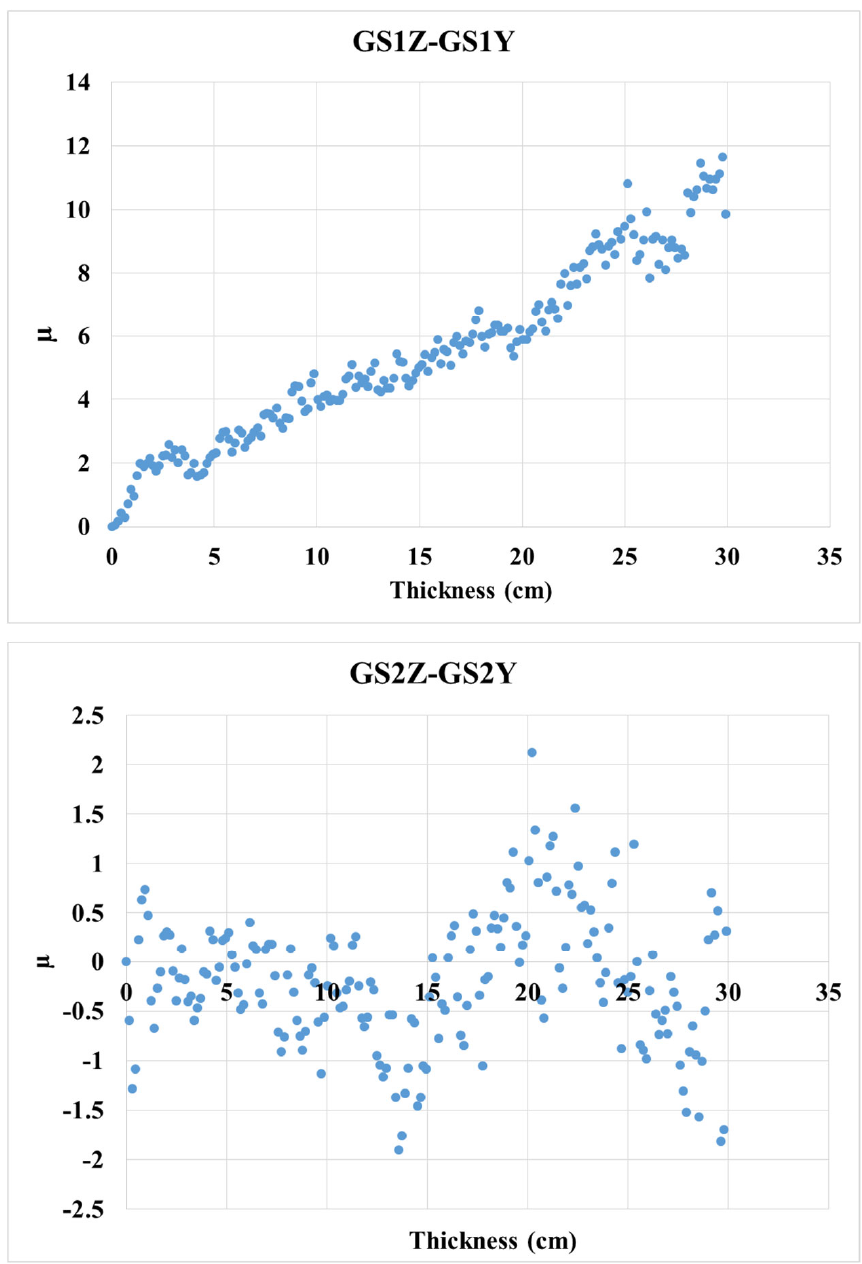
Figure 5. Comparison of CTR obtained from GS1Z − GS1Y and GS2Z − GS2Y. Accordingly, the optimal geometric structure for the metamaterial with the two phases containing graphene/h-BN was investigated by examining GS1 and GS2. Concrete, the GS1 and GS2 structures in the initial thicknesses have an exponential growth of the CTR, which is due to the production of neutrons per (n, 2n) reaction (Figures 6 and 7). A X (n, 2n) A − 1 X reactions are performed at GS1 in thicknesses between zero and 3.4 cm, while neutrons are produced at GS2 in thicknesses up to 2.3 cm.